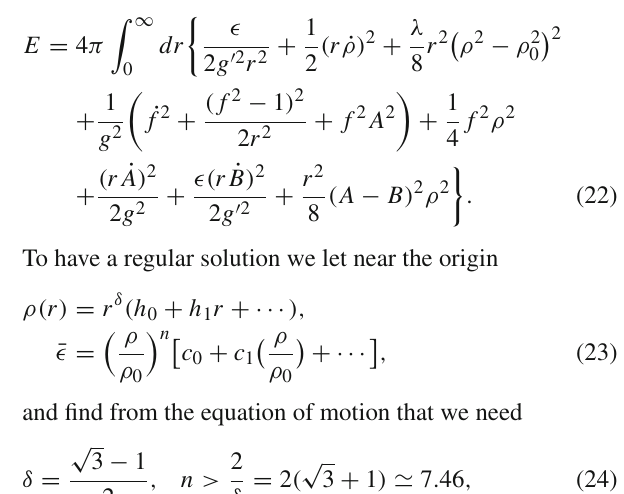
Fig. 2 Theelectroweakdyonsolution.Theredcurvesrepresentthesin- gular Cho–Maison dyon and the blue curves represent the finite energy dyon obtained by (21). Here we have put A 0 = M W / 2 and Z = A −